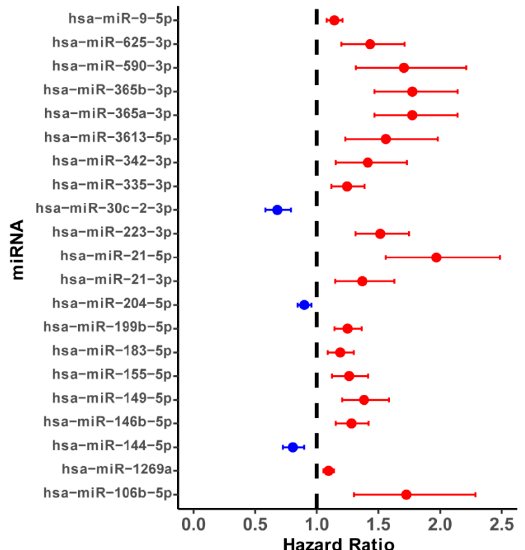
Figure 1. The forest plots of hazard ratios (HR) of top 21 most significant survival associated miRNAs in ccRCC ( p -value < 0.001) . Red represents the risk factors (HR > 1) and blue represents protective factors (HR <